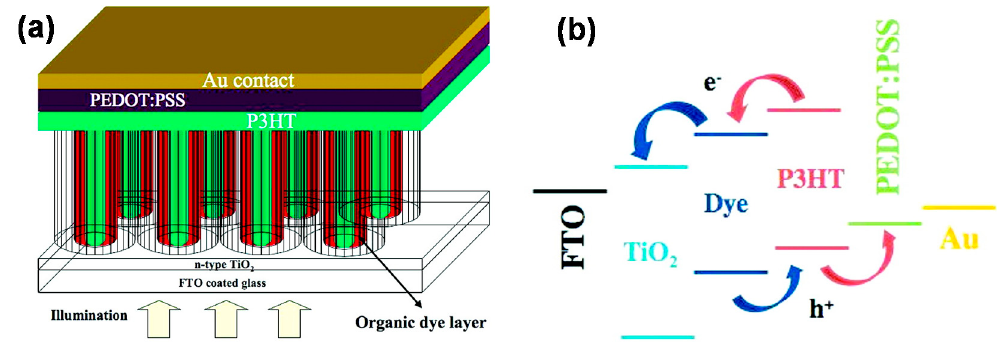
Figure 13. Schematic diagram of ( a ) 1D TiO 2 NT-SSDSCs in the frontside-illumination condition; and ( b ) energy level positions and charge transfer processes of the SSDSCs. Reprinted with permission from [58]. Copyright 2009 American Chemical Society.